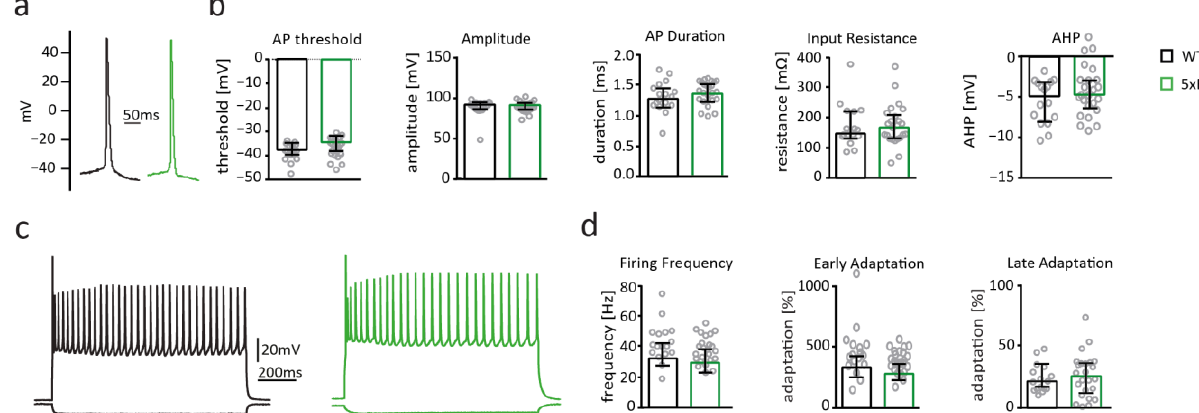
Figure 5. 5xFAD somatosensory cortex pyramidal cells display unaltered intrinsic electrophysiological properties and firing behavior. ( a ) Example traces of action potentials recorded from pyramidal cells of the somatosensory cortex of wildtype (WT) (black) and 5xFAD (blue) mice. ( b ) Bar graphs displaying action potential (AP) threshold, AP amplitude and duration, input resistance, and afterhyperpolarization (AHP) of pyramidal cells from WT (black; n = 17) and 5xFAD mice (green; n = 24). ( c ) Example traces of action potential firing patterns recorded from somatosensory cortex pyramidal cells of WT (black) and 5xFAD (green) mice. ( d ) Bar graphs of firing frequency, early and late adaption of pyramidal cells from WT (black), and 5xFAD (green) mice. Data in bar graphs are shown as median ± interquartile range. Empty grey circles depict single data points.